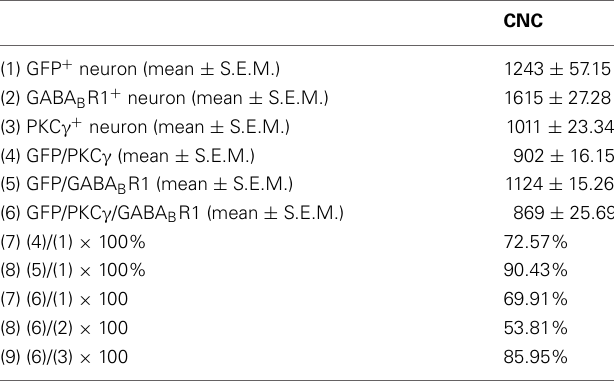
Table 1 | The numbers of neurons immunopositive for GFP, GABA B R1, PKC γ , and triple-labeled neurons in CNC of the GAD67-GFP transgenic mice.